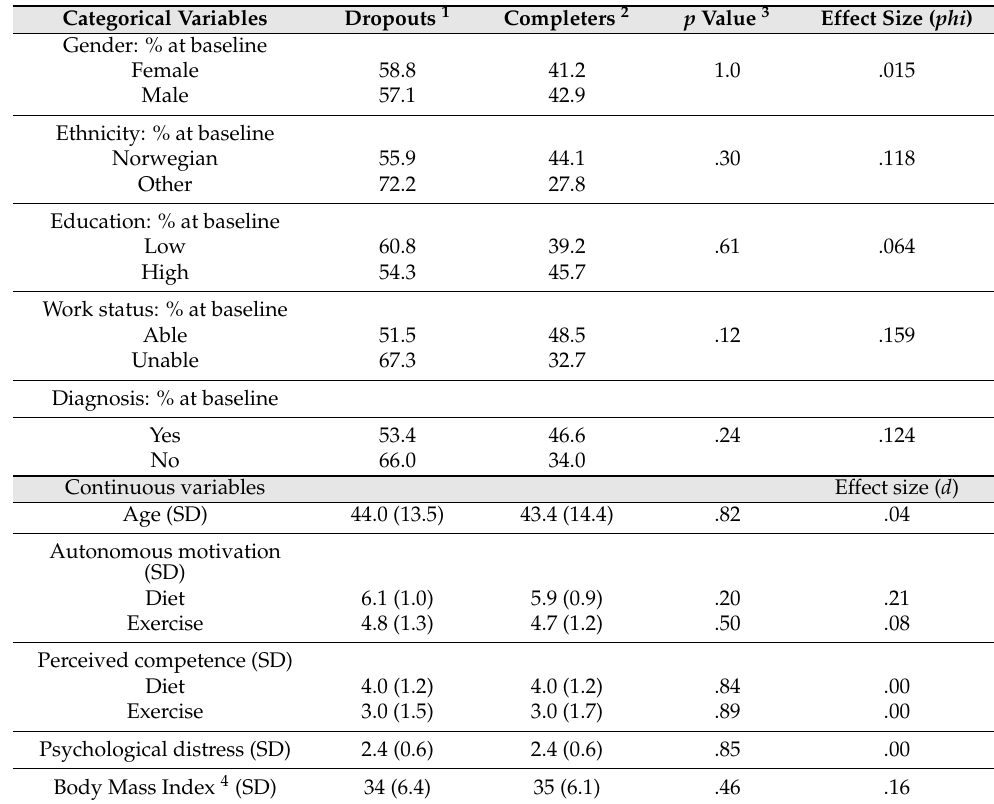
Table 2. Differences in distribution of baseline categorical and baseline continuous variables be- tween completers and dropouts at 12 months.